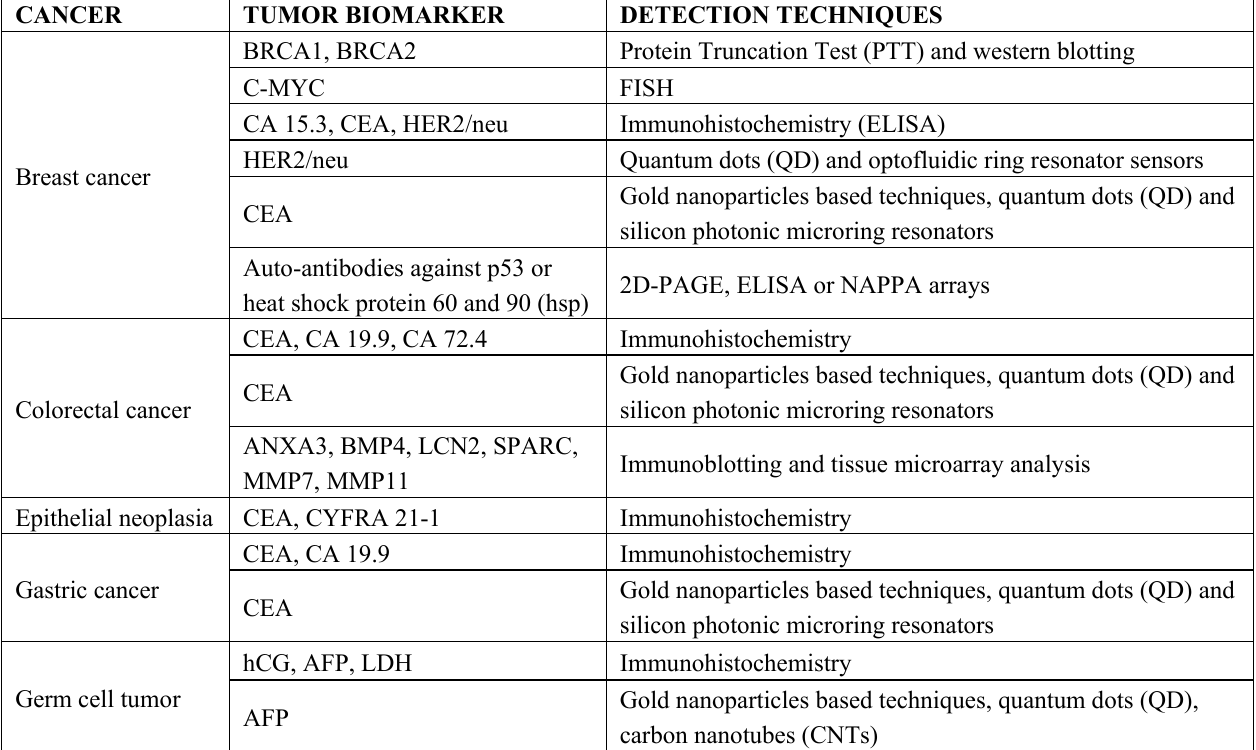
Table 1. A list of cancer biomarkers detected by novel sensors based on nanoproteomics approaches.